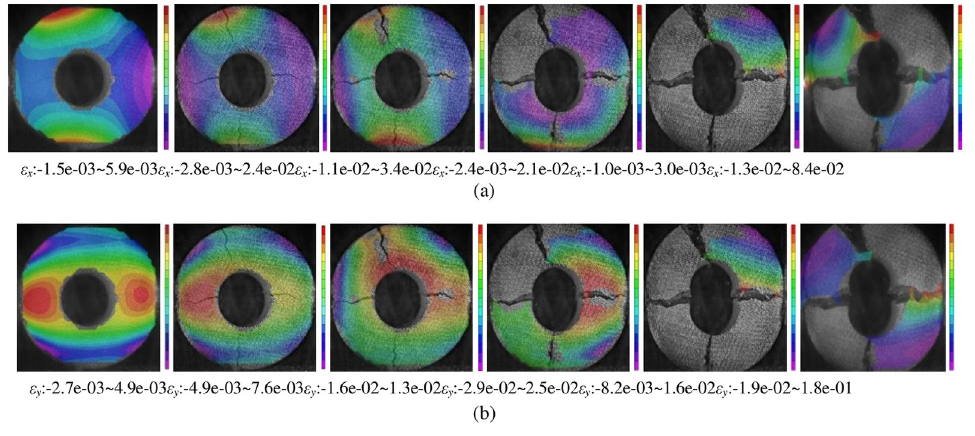
Fig 8. Strain history of the circular granite under radial impact load (sample GD2-2). (a) Evolution of the strain cloud image in the x direction (the direction of the impact stress wave propagation is the x direction). (b) Evolution of the strain cloud image in the y direction (the direction of vertical impact stress wave propagation is the y